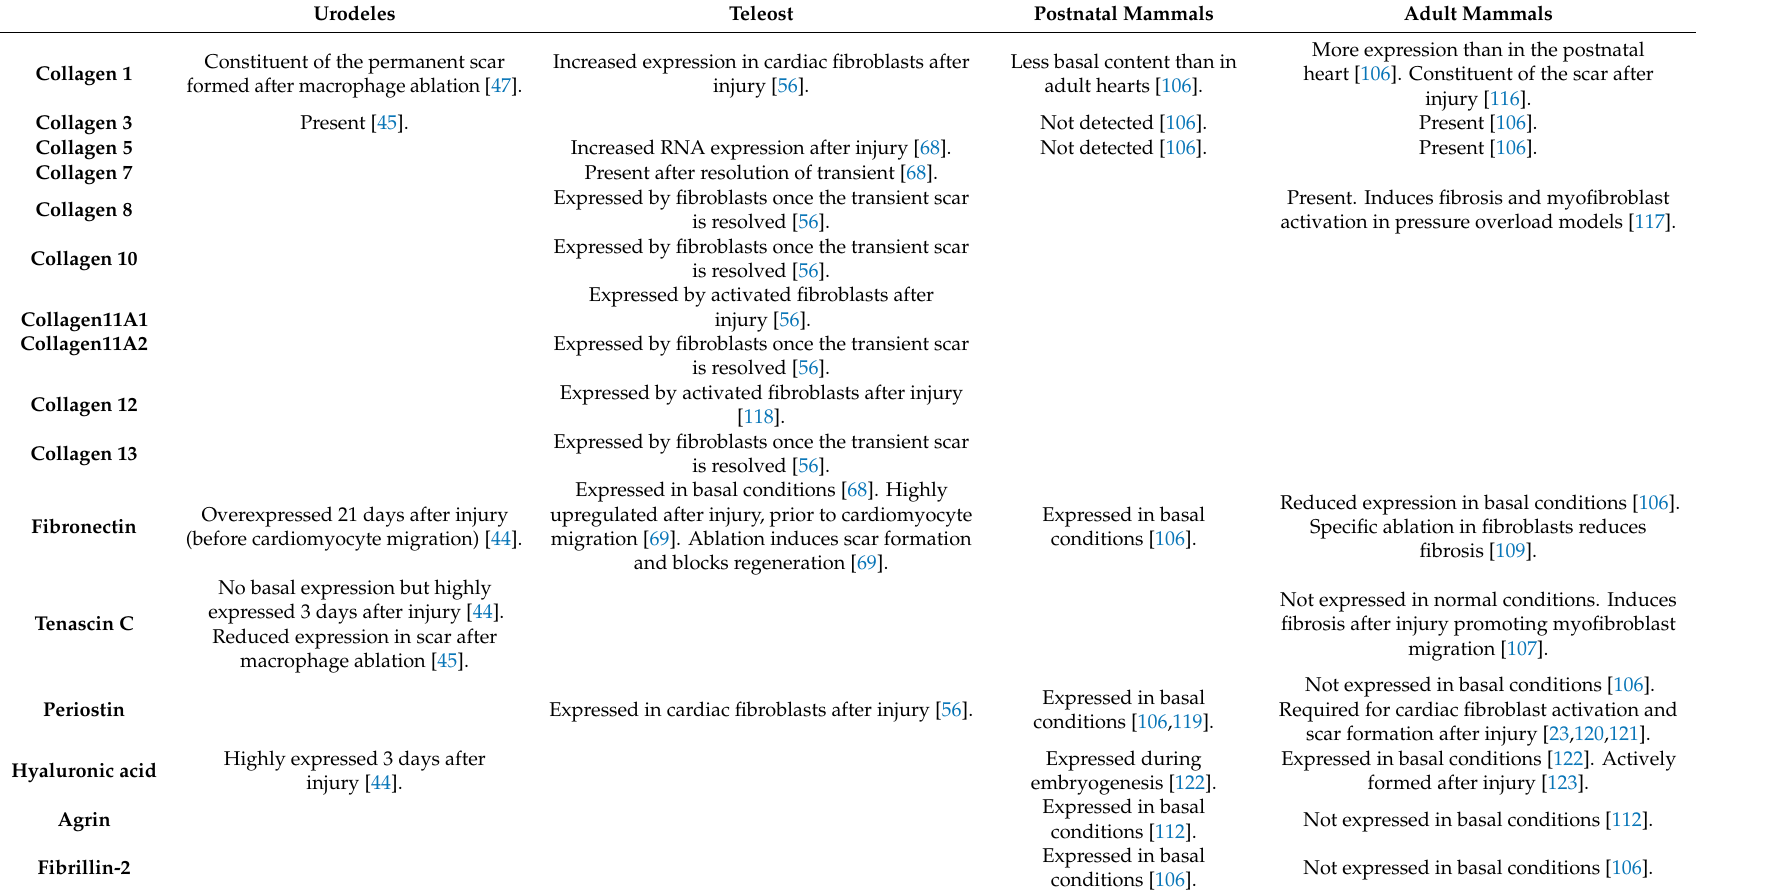
Table 1. Extracellular matrix (ECM) proteins in regenerative and nonregenerative